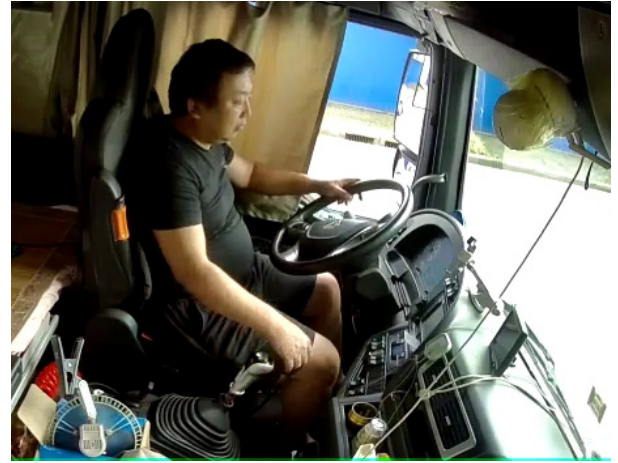
Figure 4. Transitional posture of one-handed driving.